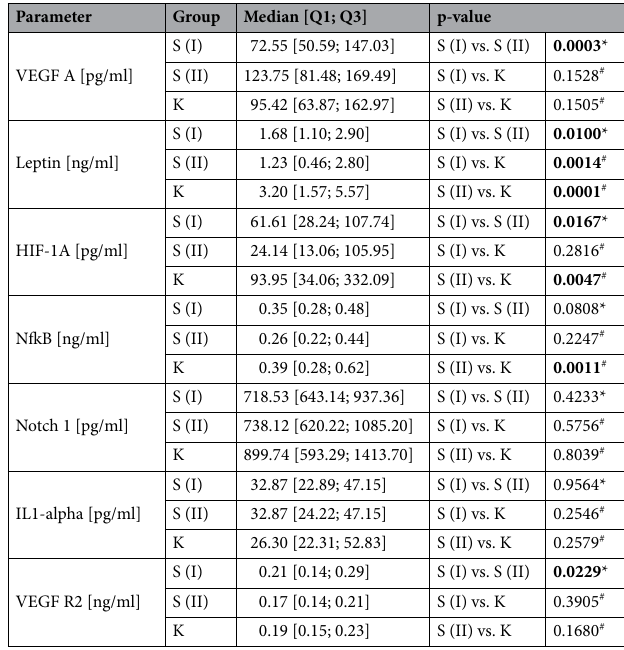
Table 6. Serum concentration of biochemical parameters. Data are presented as median [Q1; Q3]. HIF-1A, hypoxia-inducible factor 1 alpha; IL1-alpha, interleukin 1 alpha; NfkB, nuclear factor kappa-light-chain- enhancer of activated B cells; Notch 1, Notch protein 1; Q1: first quartile; Q3: third quartile; VEGF A, vascular endothelial growth factor A; VEGF R2, vascular endothelial growth factor receptor 2. (I): value before intervention; (II): value after the intervention. *Wilcoxon test; # Mann–Whitney test. Significant values are given in